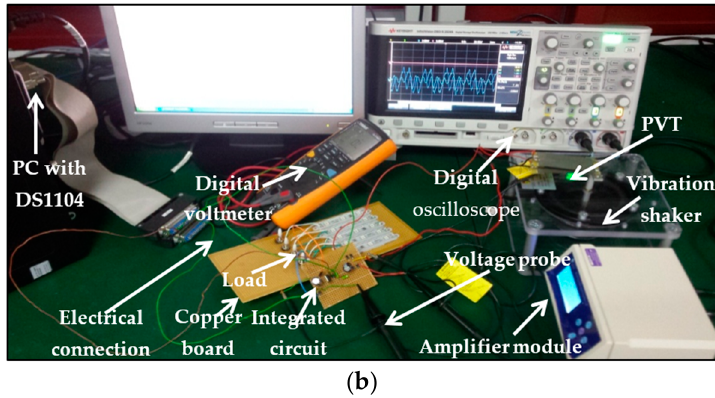
Figure 9. ( a ) dSPACE-based PEHS prototype implementation block diagram; and ( b ) in-lab PEHS prototype experimental setup. Table 2. Equipment list for the experimental setup.